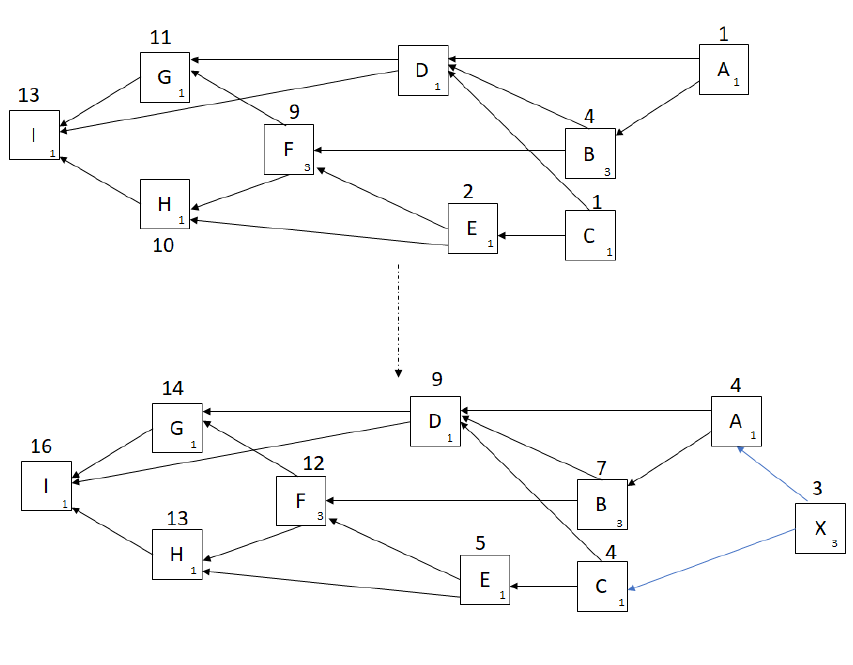
Figure 11. Weight assignments before and after a newly-issued transaction, X.